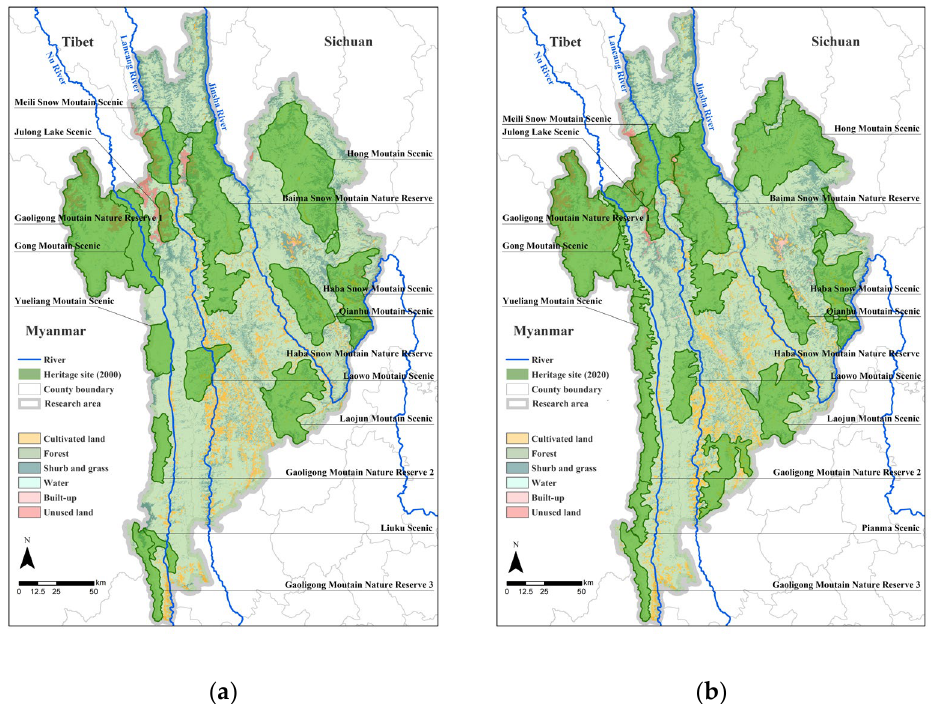
Figure 3. Map of the Three Parallel Rivers Natural World Heritage Site in 2000 ( a ) and 2020 ( b ). The boundaries of the Three Parallel Rivers Natural World Heritage Site are drawn with reference to the 2001 Master Plan of the Three Parallel Rivers Scenic Area of the Nu, Lancang, and Jinsha rivers prepared by the Yunnan Provincial Institute of Urban and Rural Planning and Design and the 2011 Revision of the Master Plan of the Three Parallel Rivers Scenic Area of Yunnan Province, as well as the UNESCO map of heritage sites (https://whc.unesco.org/ (accessed on 1 April